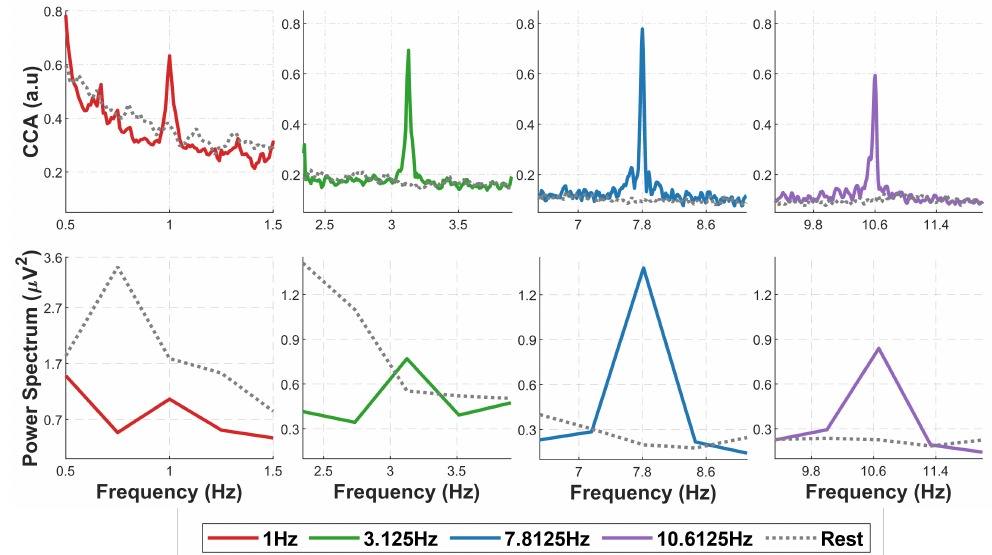
Figure 3. CCA (top row) and Power Spectrum (bottom row) of 20-s-long EEG data segments relative to visual stimulation at (from left to right) 1, 3.125, 7.8125, 10.6125 Hz and on resting state data adjacent to the same segments, from a representative